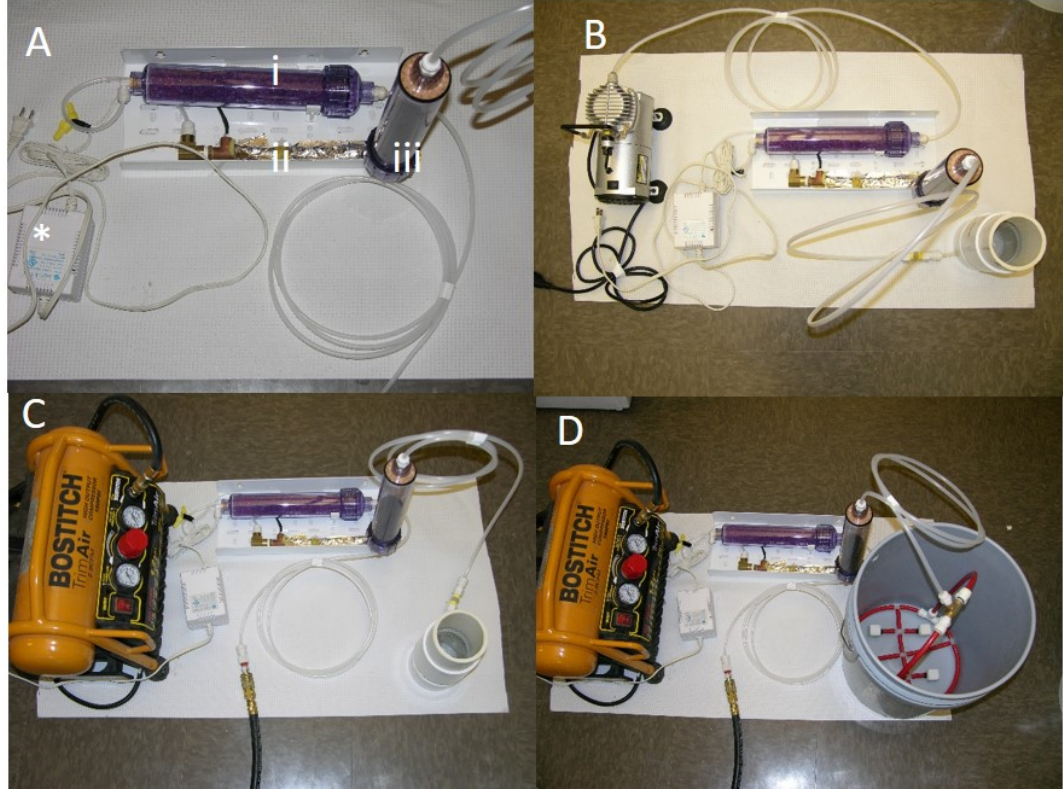
Figure 1. I 2 vapor infusion (I 2 VP) system with different electric powered compressors. ( A ) Basic components of the I 2 VP system. Order taken by air ( i ) cartridge with moisture trapping beads ( ii ) heated tube to warm up air ( iii ) cartridge containing iodine coated resins. ( B – D ) various configurations of the I 2 VP diffuser System. ( B ) Air supplied by a lower capacity pump, Gilford